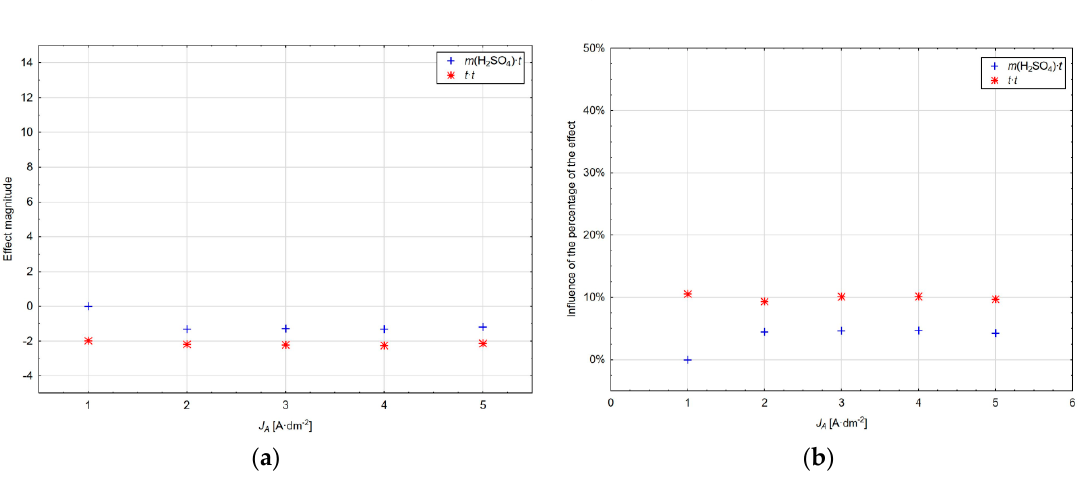
Figure 9. ( a ) The magnitude of the model two-level effects for J A = 1 to 5 A·dm − 2 ; ( b ) The influence of the percentage of the model two-level effects for J A = 1 to 5 A·dm − 2 .